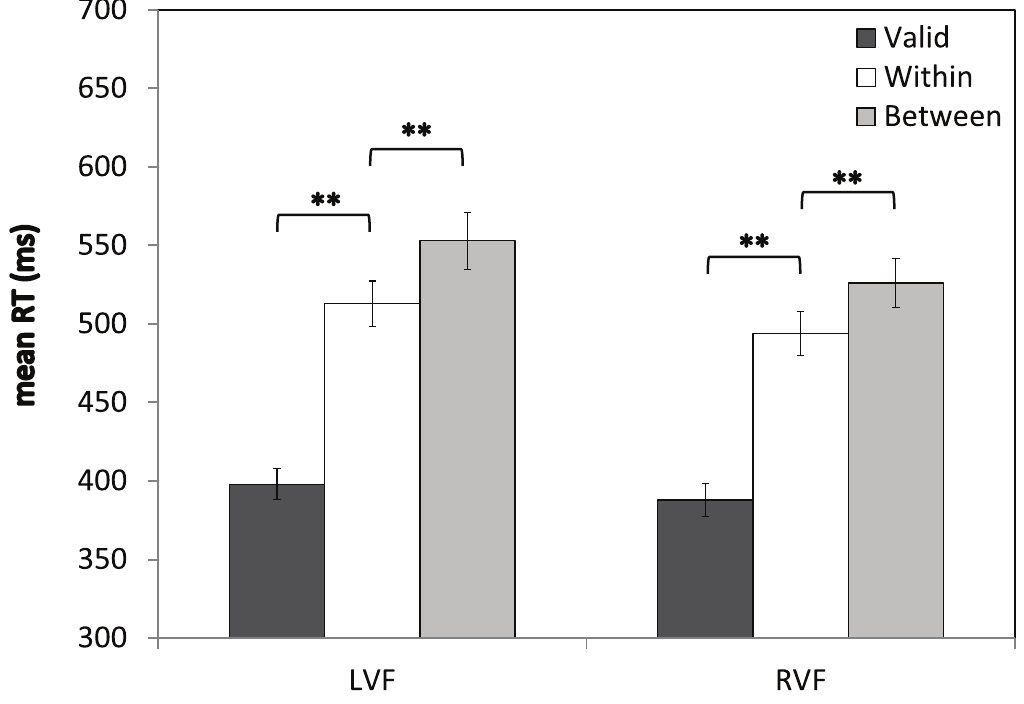
Figure 5. Visual field × Validity interaction. Mean RTs (ms) are shown for the three different target types in the left visual field (LVF) and right visual field (RVF). Error bars indicate ±1SEM; ** indicates p